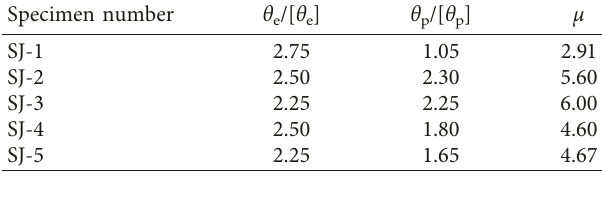
Table 4: Ductility factor of specimens. Specimen